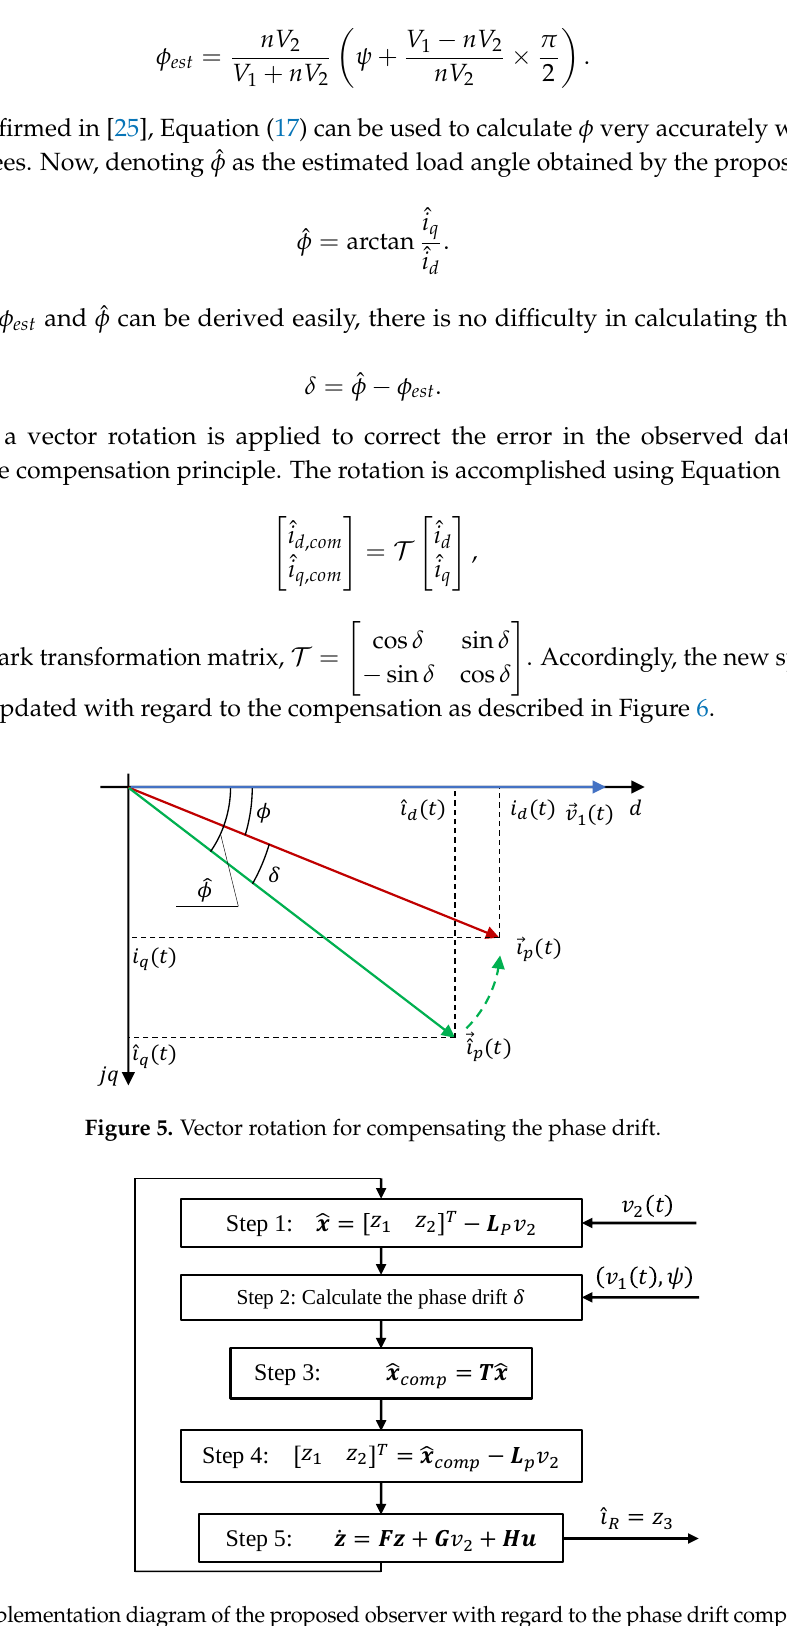
Figure 6. Implementation diagram of the proposed observer with regard to the phase drift